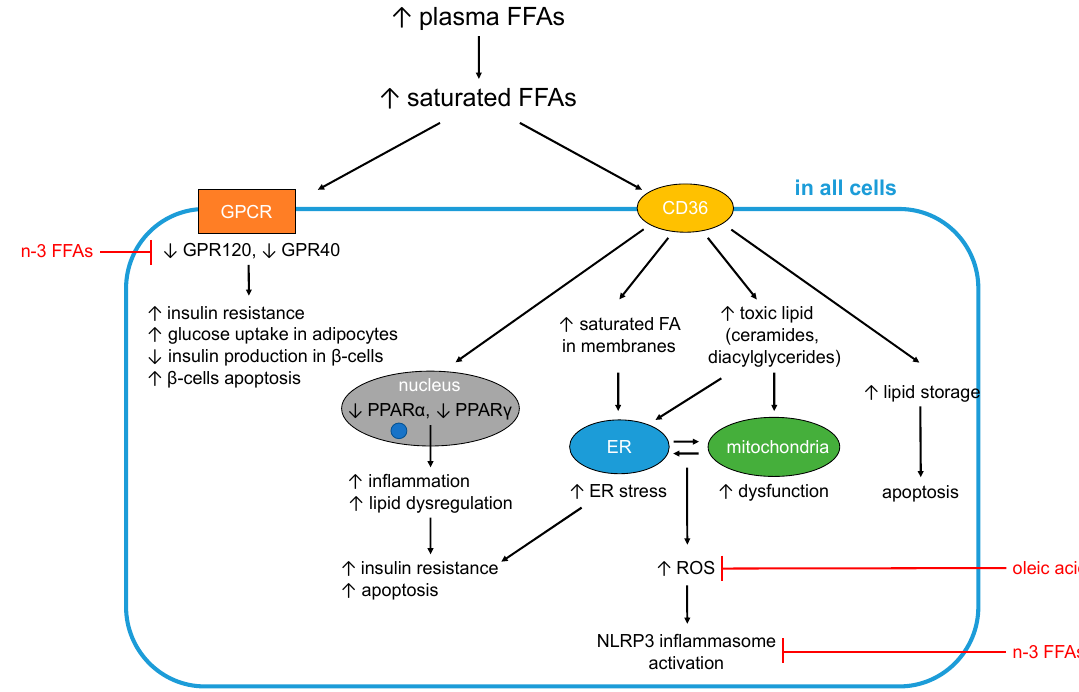
Figure 1. Schematic summarising the common effects of excess FFAs and saturated FFAs on metabolism and the different mechanisms through which insulin resistance can occur. CD36: Fatty acid translocase; GPCR (G protein-coupled receptor); ER (Endoplasmic reticulum); FA (fatty acids); FFA (free fatty acids); NLRP3 (NACHT, LRR and PYD domains-containing protein 3); PPAR (peroxisome proliferator-activated receptors); ROS (reactive oxygen species). GPCR and PPAR receptors have been introduced in Section 2.2.